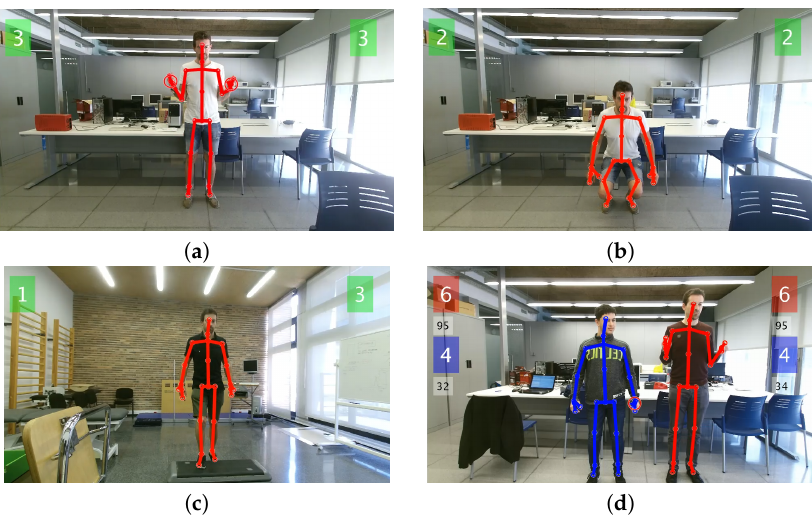
Figure 2. Screenshots of HemoKinect during the different exercises: ( a ) simultaneous elbow flexion exercise, without load; ( b ) knee flexion exercise (squat); ( c ) ankle exercise (step climb); ( d ) elbow flexion exercise in two-player mode. The repetition count for each exercise and individual left/right joint of interest is displayed in the respective left/right corner of the screen. In two-player mode, the repetition count for the second player appears stacked directly below the first players’ count, in a different color. In this last screenshot, the real-time angle measurement of the joints of interest is displayed, as well, in a smaller font, below the respective score box. Algorithm 1: Joint flexion (elbow and knee) count algorithm. The detection is a two-step procedure that firstly checks that a flexed status has been reached, and then, an extension is observed to count the exercise as